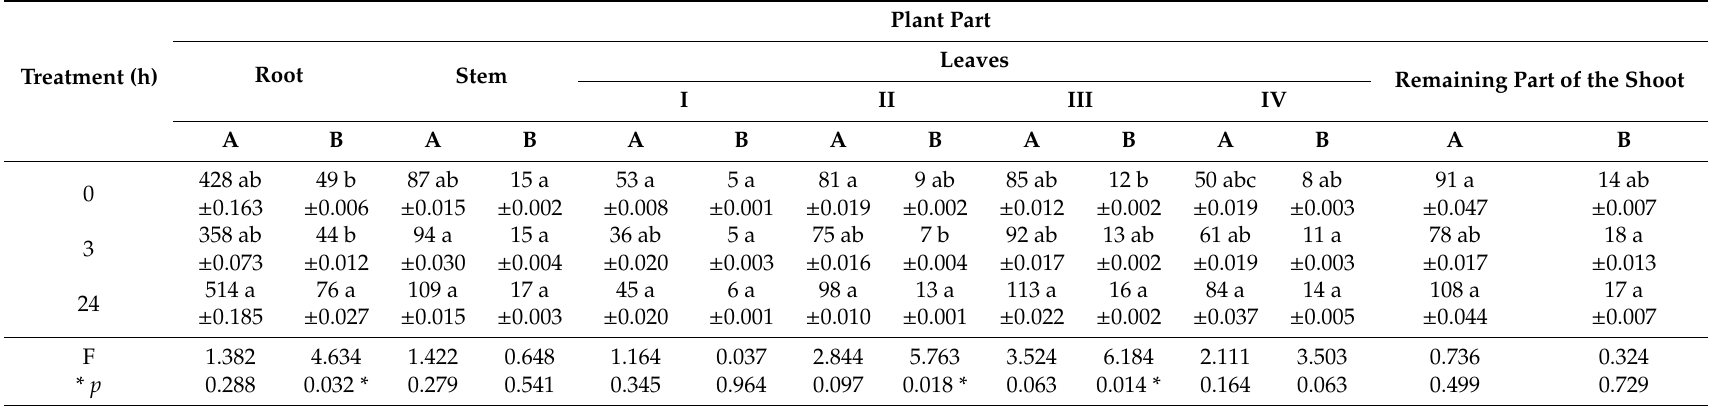
Table 7. Fresh mass—A and dry mass—B (mg) of triticale ( × Triticosecale Wittm. ex A.Camus) plants grown from grains irradiated with a helium-neon (He-Ne) laser by 3 and 24 h; mean ± SD (n = 10) values marked with di ff erent letters di ff er statistically according to Tukey’s test at * p ≤ 0.05. Plant Part Leaves Root Stem Treatment (h) Remaining Part of the Shoot I